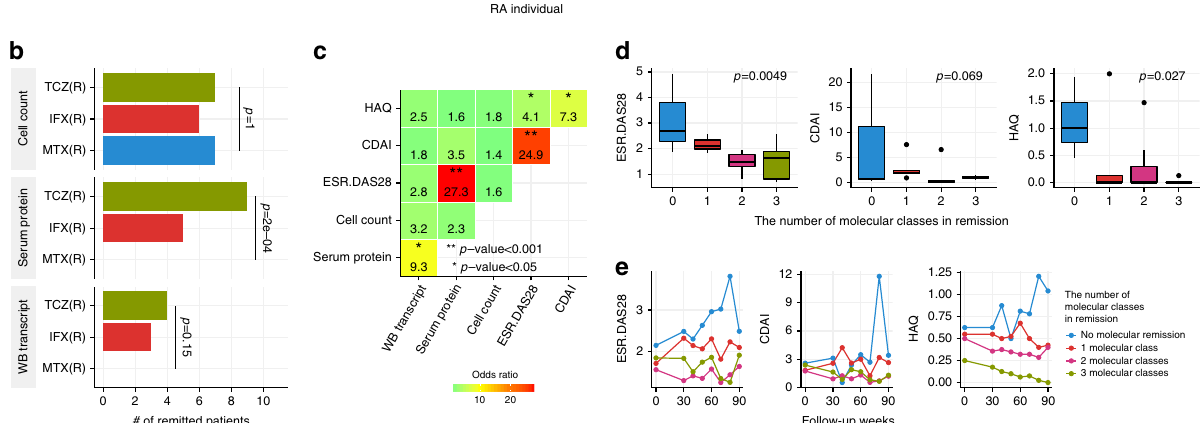
Fig. 3 Relationship between MR and disease severity indexes. a MR pro fi les along with disease severity indexes at week 24. R and IR indicate drug responders and inadequate responders, respectively. Each column represents MR and disease severity indexes of a single patient with RA. Disease severity indexes include DAS28-ESR, CDAI, HAQ, ESR, tenderness joint counts using 28 joints (TJC28), swollen joint counts using 28 joints (SJC28), physician visual analog scale (Phys. VAS), and subject visual analog scale (Subj. VAS). b Comparison of drug effects on the induction of MR. The proportions